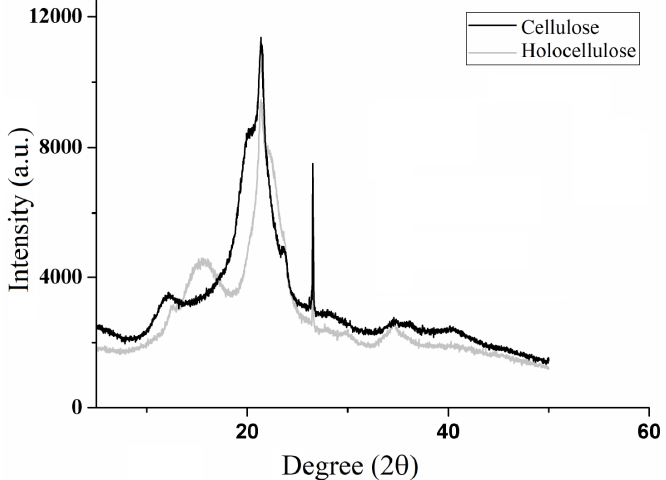
Figure 5. X ‐ ray diffratograms of holocellulose and cellulose.